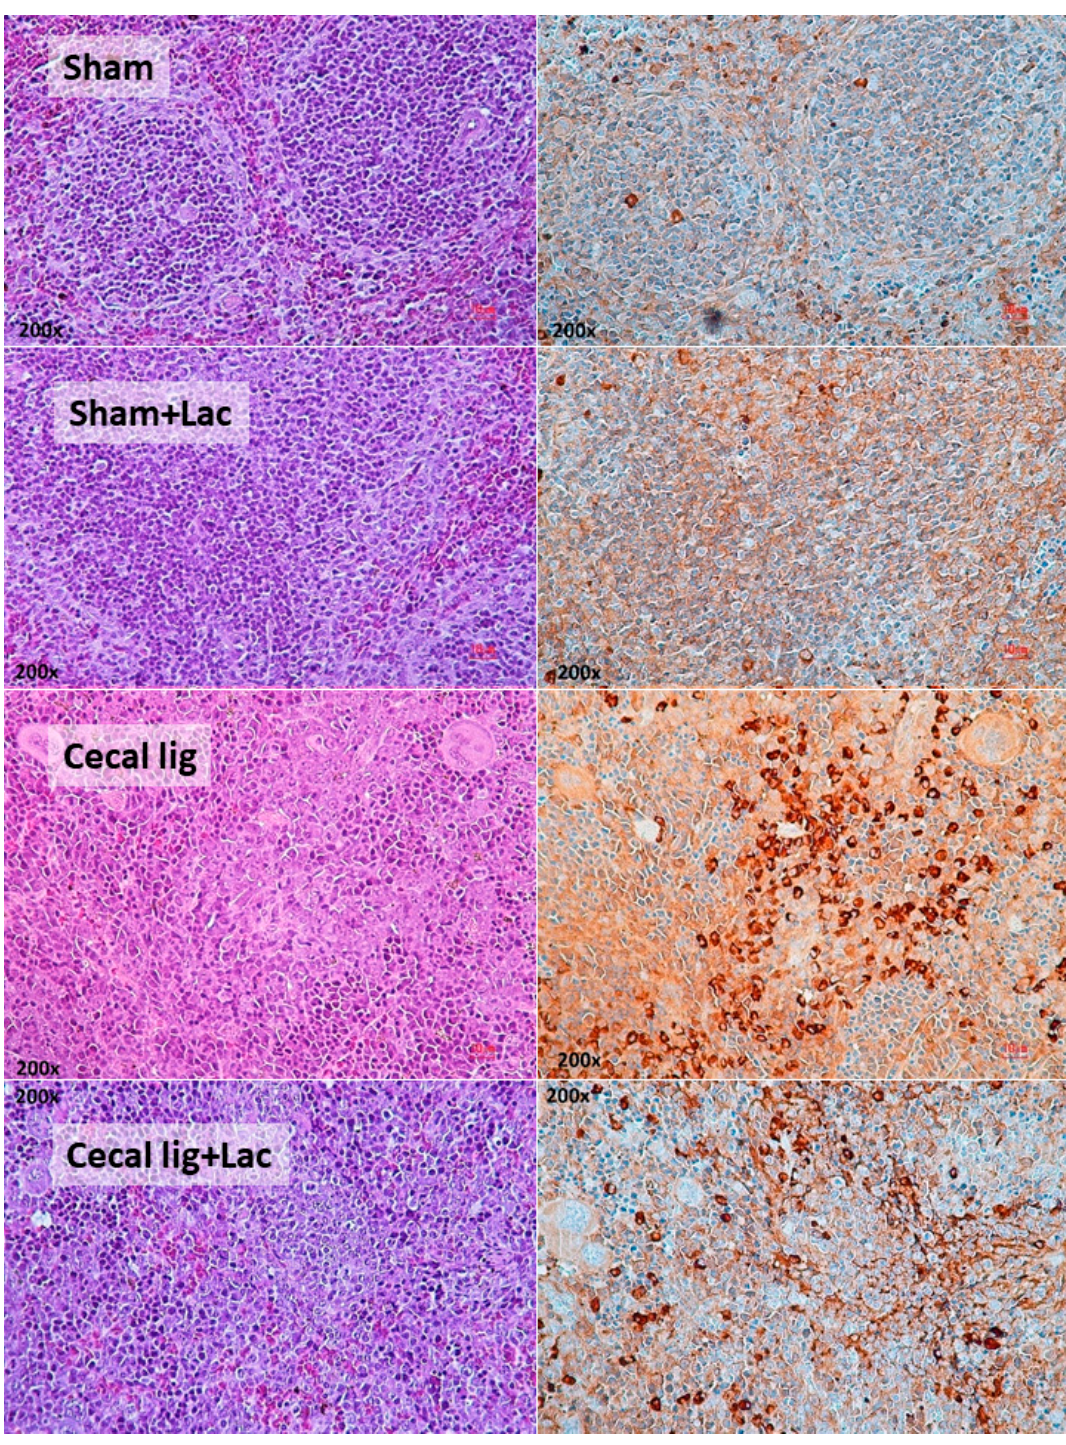
Figure 2. The representative pictures of spleen histology from mice with cecal ligation (without puncture) (Cecal lig) or sham surgery (Sham) with or without Lacticaseibacillus administration (Cecal lig + Lac and Sham + Lac) at 48 h post-surgery as stained by Hematoxylin and Eosin (H&E) stain (left column) and activated caspase 3 (apoptosis) (right column) are demonstrated (the score of apoptotic cells is presented in Figure 1K).